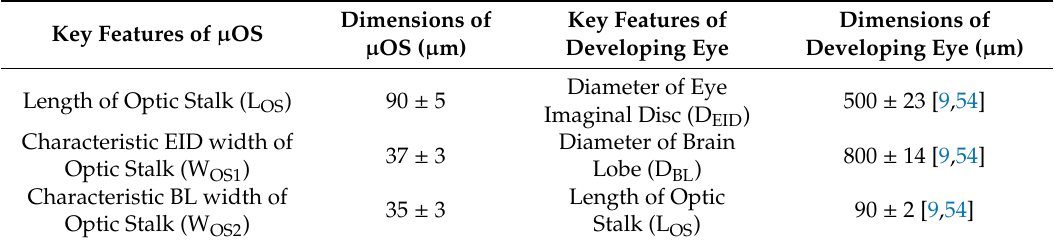
Table 1. Critical dimensions of developing optic stalk within the visual system of Drosophila